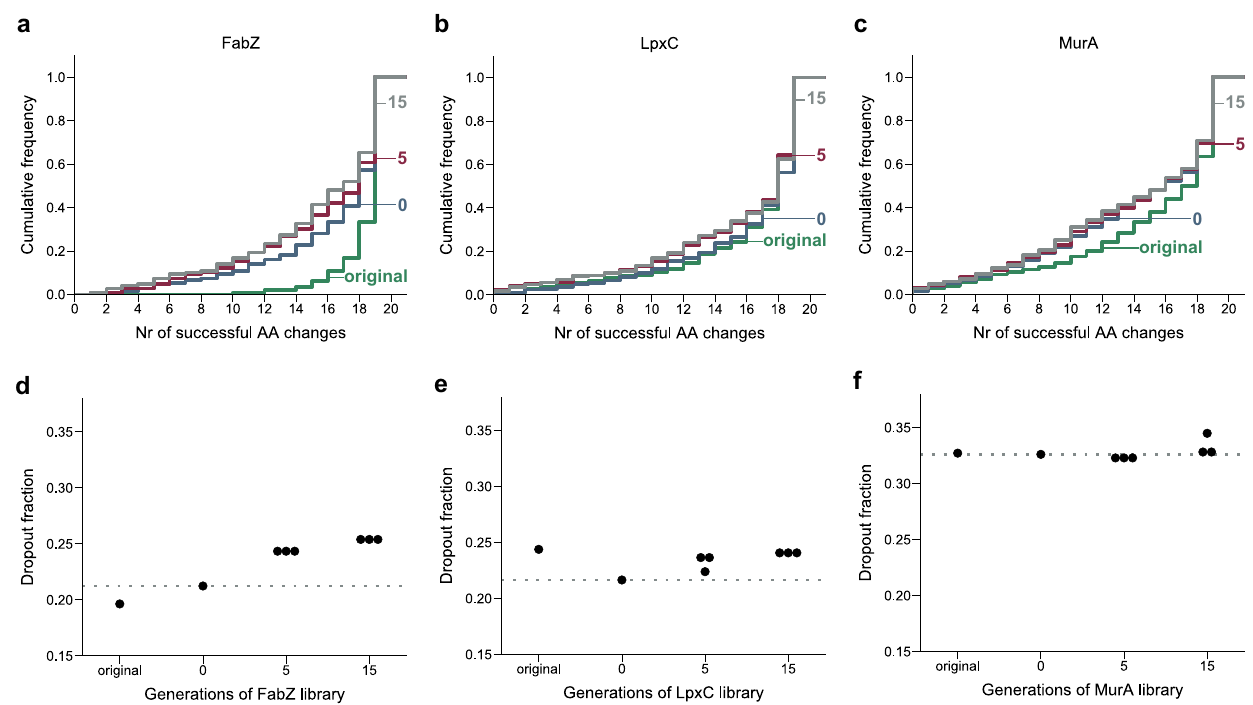
Fig. 2 | The stability of library composition across growth cycles varies for differentproteins. Thecumulativefrequencydistributionofsuccessfulaminoacid substitutions perresidue, i.e. edits that couldbedetected by sequencing,isshown for the FabZ ( a ), LpxC ( b ) and MurA ( c ) libraries. Different curves represent the library composition at different points of sequencing. In case multiple replicates were sequenced (for samples 5 and 15), the fi rst replicate is shown. This fi gure shows the dropout fraction, i.e. the fraction of edits detected by fewer than 10 reads, in function of the number of generations the FabZ ( d ), LpxC ( e ) or MurA ( f )